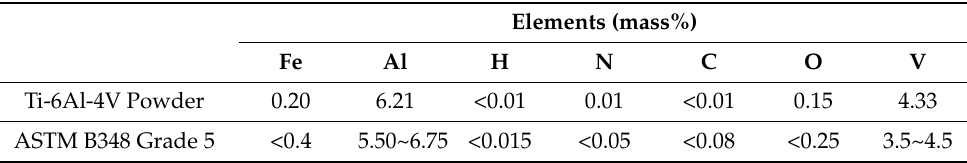
Table 1. Chemical composition of Ti-6Al-4V alloy powder used as a raw material in this study compared to ASTM B348 Grade 5 standard values.